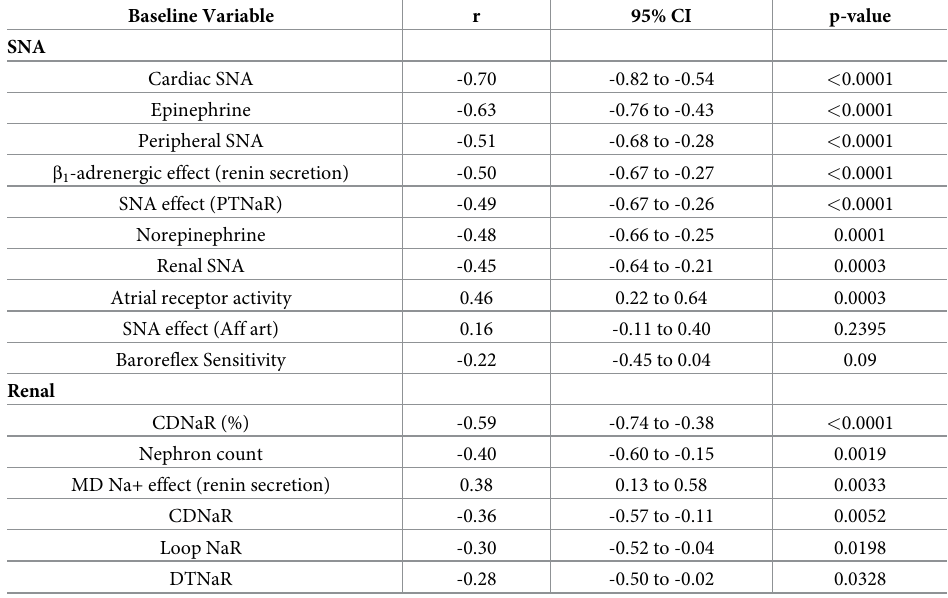
Table 3. Correlations among baseline variables and the change in mean blood